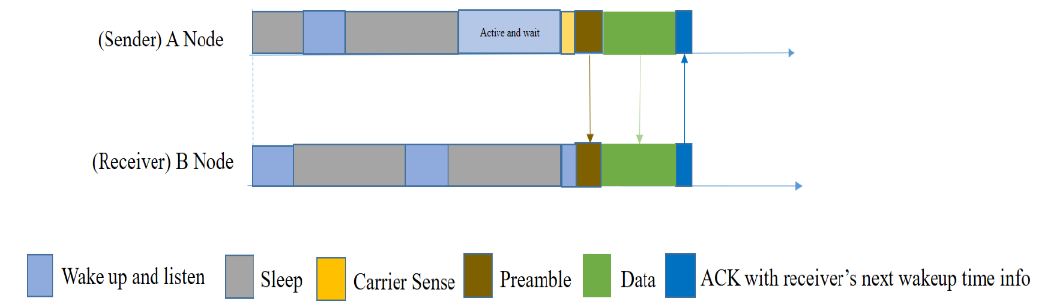
Figure 6. Packet transmission in Wise-MAC [29].